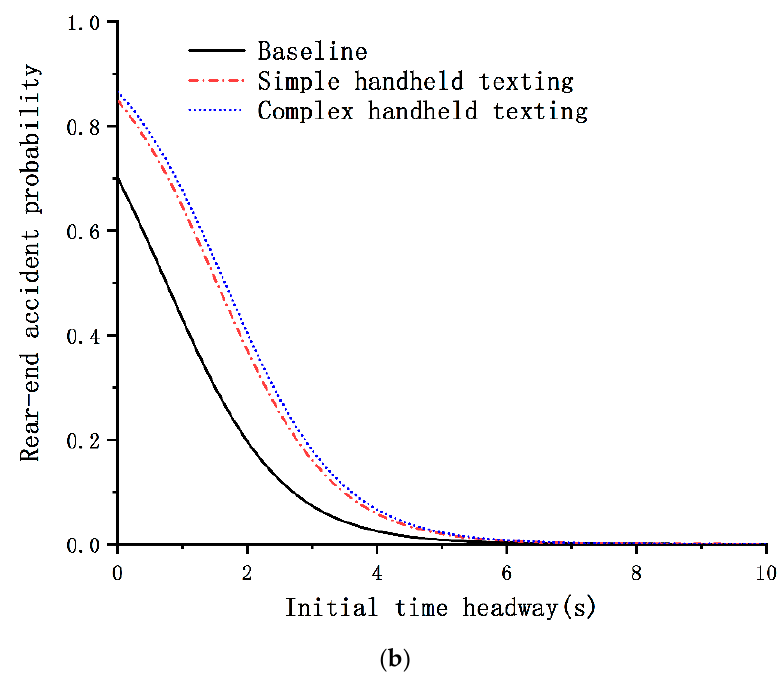
Figure 4. Relationship between rear-end accident probability and the significant variables. ( a ) Non-distracted driving; ( b ) LV deceleration rate = 8 m / s 2 . 3.3. E ff ects of LV Deceleration Rate and Actual Driving Behavior Characteristics on the Observed